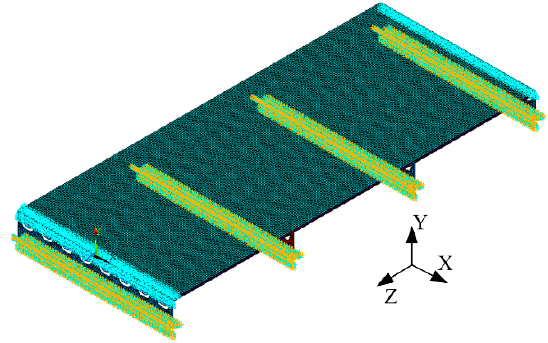
Figure 8. Simplified finite element model of steel box girder section.